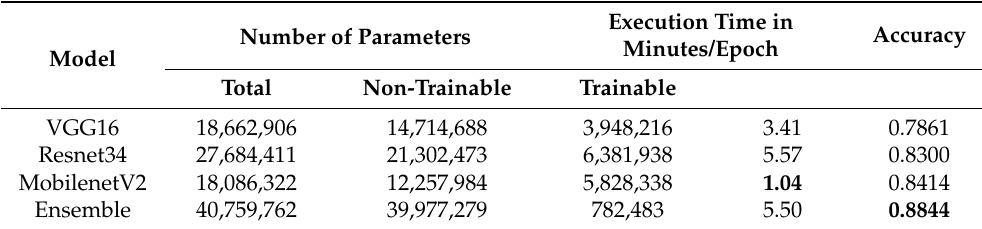
Table 5. Comparison of execution time and accuracy for various models. Best results are indicated in bold.